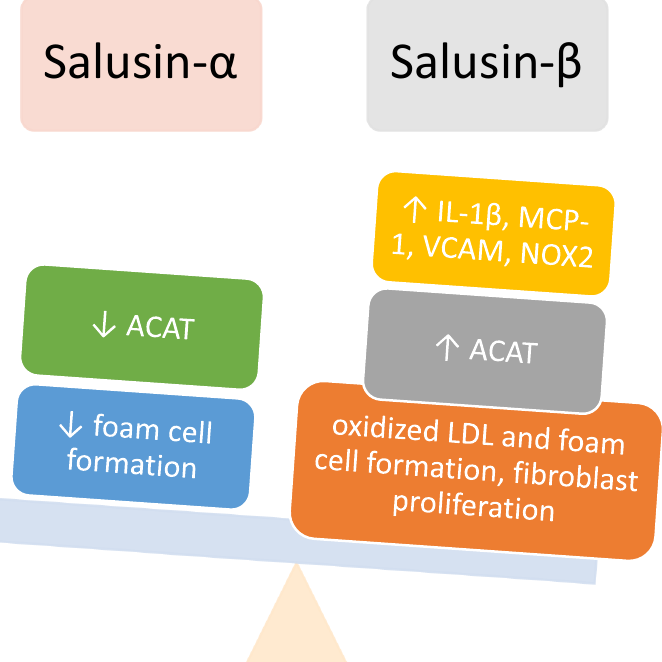
Figure 2. Modulatory effects of salusin- α and - β . ACAT—acyl-CoA: cholesterol acyltransferase 1; IL-1 β —interleukin-1 β , MCP—monocyte chemoattractant protein-1; VCAM—vascular cell adhesion molecules; NOX2—NADPH oxidase 2.